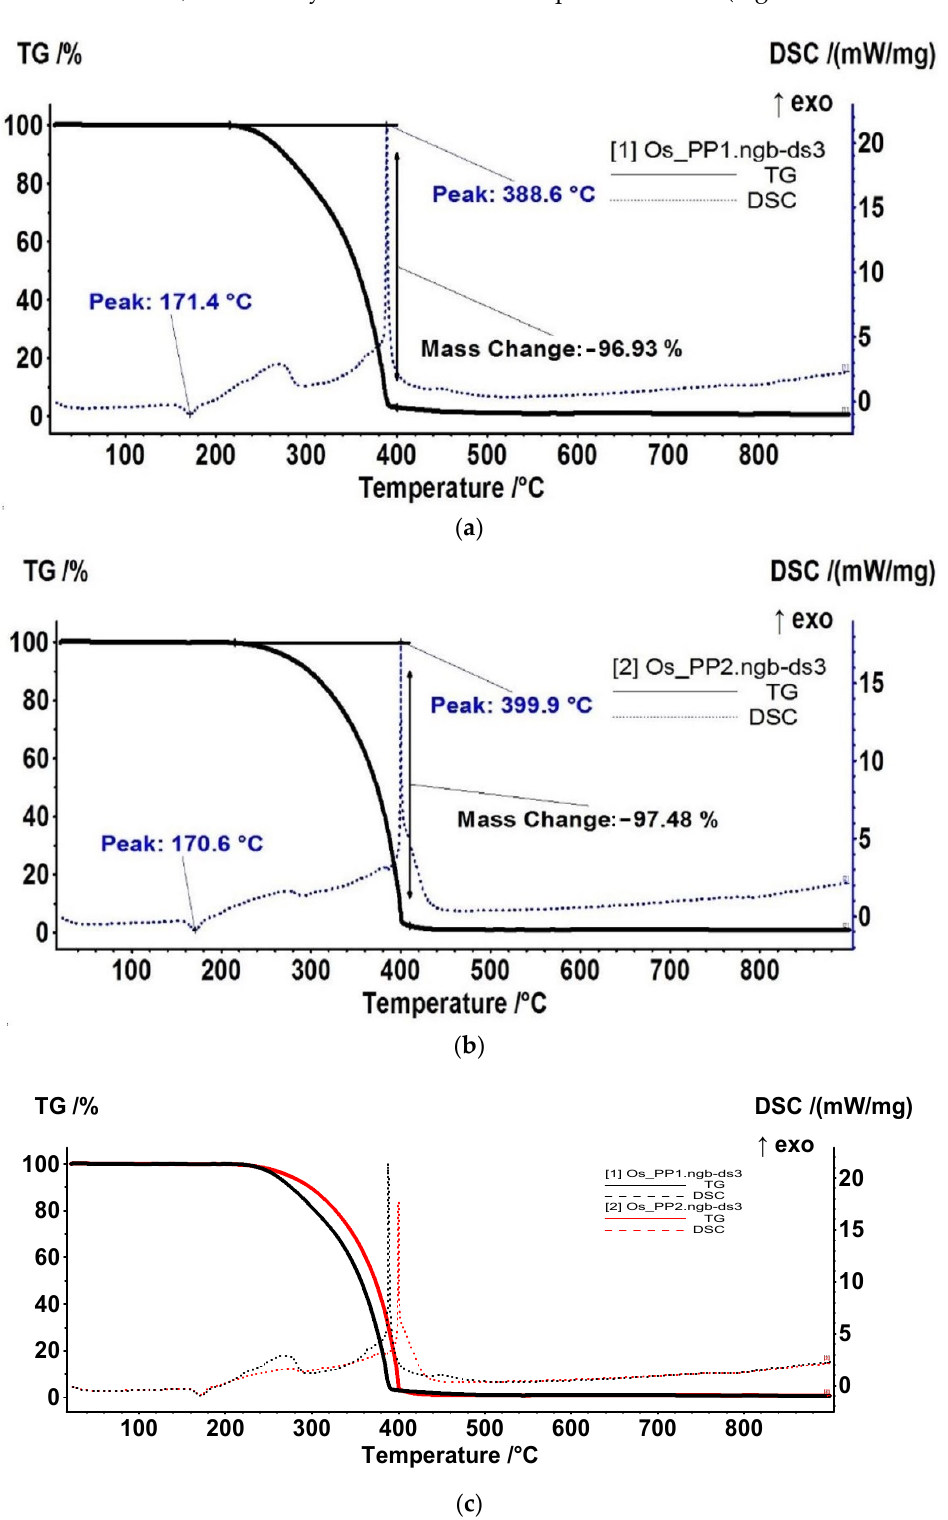
Figure 10. TG–DSC curves for osmium nanoparticles-polypropylene hollow fibers composite membranes: Os-PP1 ( a ); Os-PP2 ( b ); and their overlap ( c